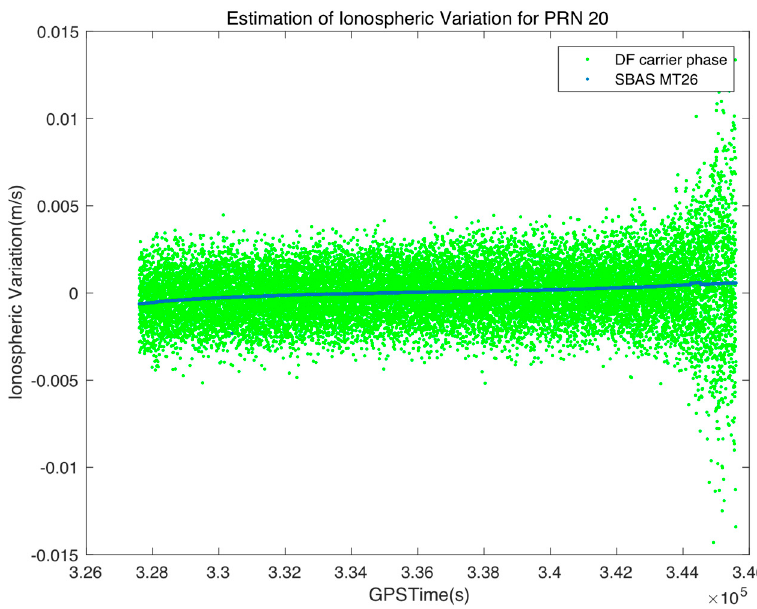
Figure 6. Result of the ionospheric error rate estimated by the dual-frequency carrier phase and SBAS MT26.